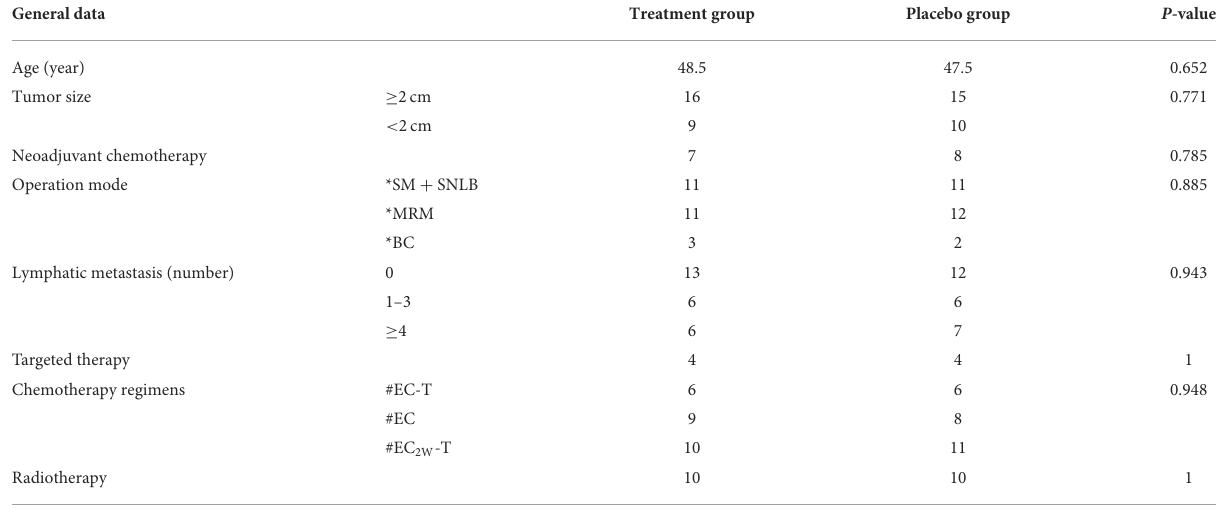
TABLE 2 The general information of recruited